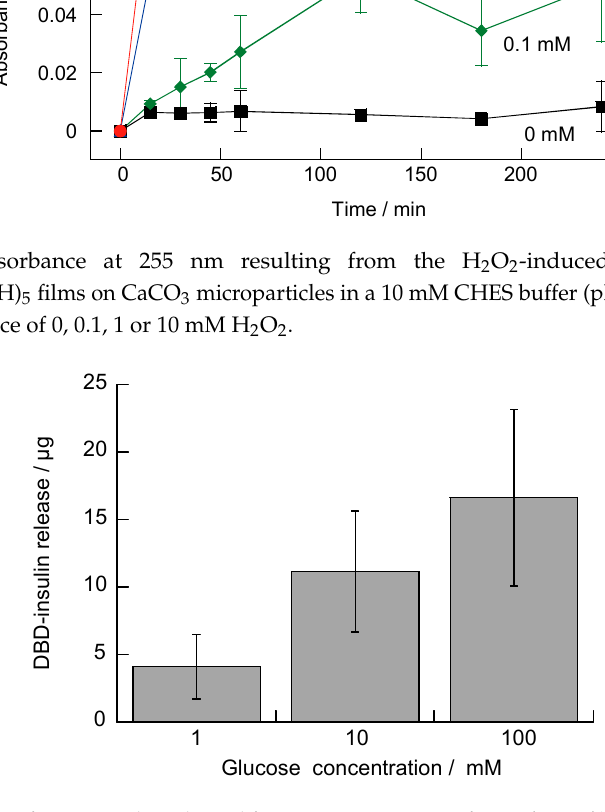
Figure 12. Amounts of DBD-insulin released from 1 mg quantities of PAH/GOx/(SA-PAH/PBA-PAH) 5 film-coated CaCO 3 microparticles in a 10 mM HEPES buffer (pH 7.4, containing 150 mM NaCl) in the presence of 1, 10 or 100 mM glucose.